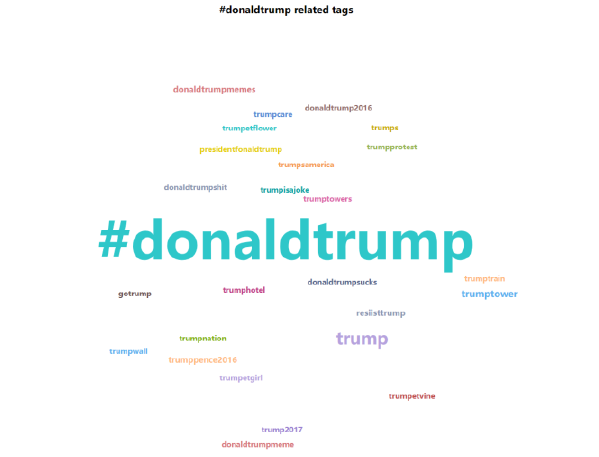
Figure 8 visualization of the event view on y-z